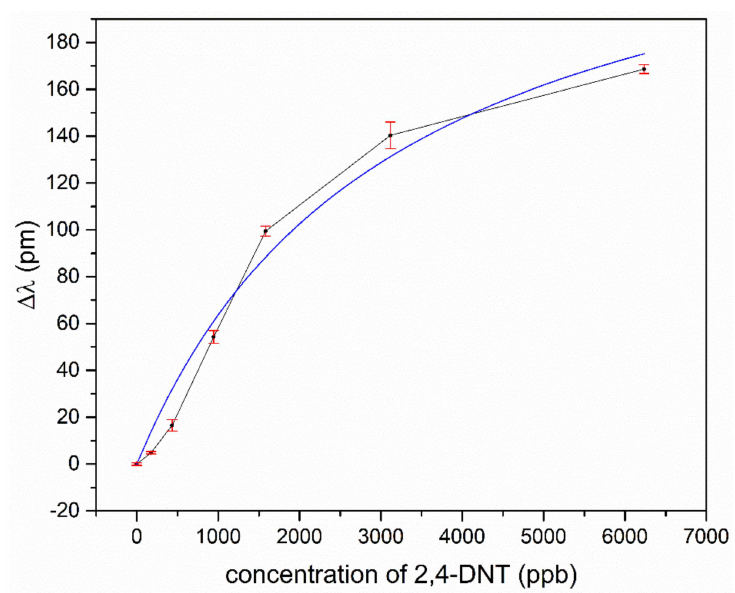
Figure 8. Shift of the resonant transmission minimum to a longer wavelength in dependence of DNT